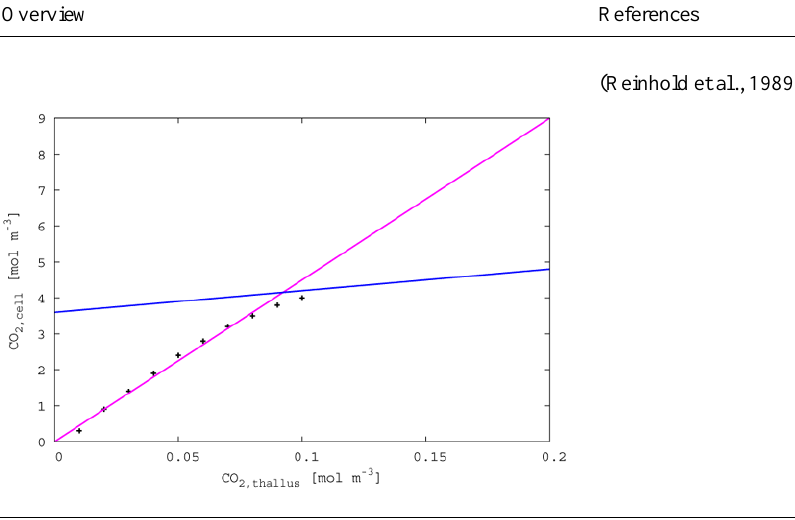
Fig. B14. CO 2 concentration in the chloroplasts, CO 2,cell , as a function of pore space CO 2 concentration CO 2,thallus . The black data points are taken from the study of Reinhold et al. (1989). The minimum of the magenta and blue lines is used to fit the